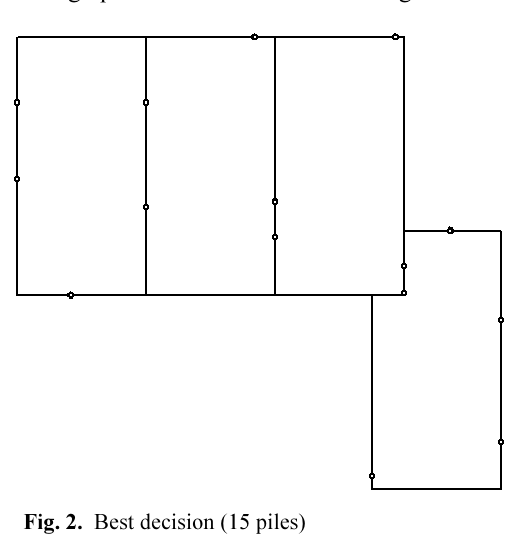
Fig. 2. Best decision (15 piles) The results of GA and SA are compared in Table